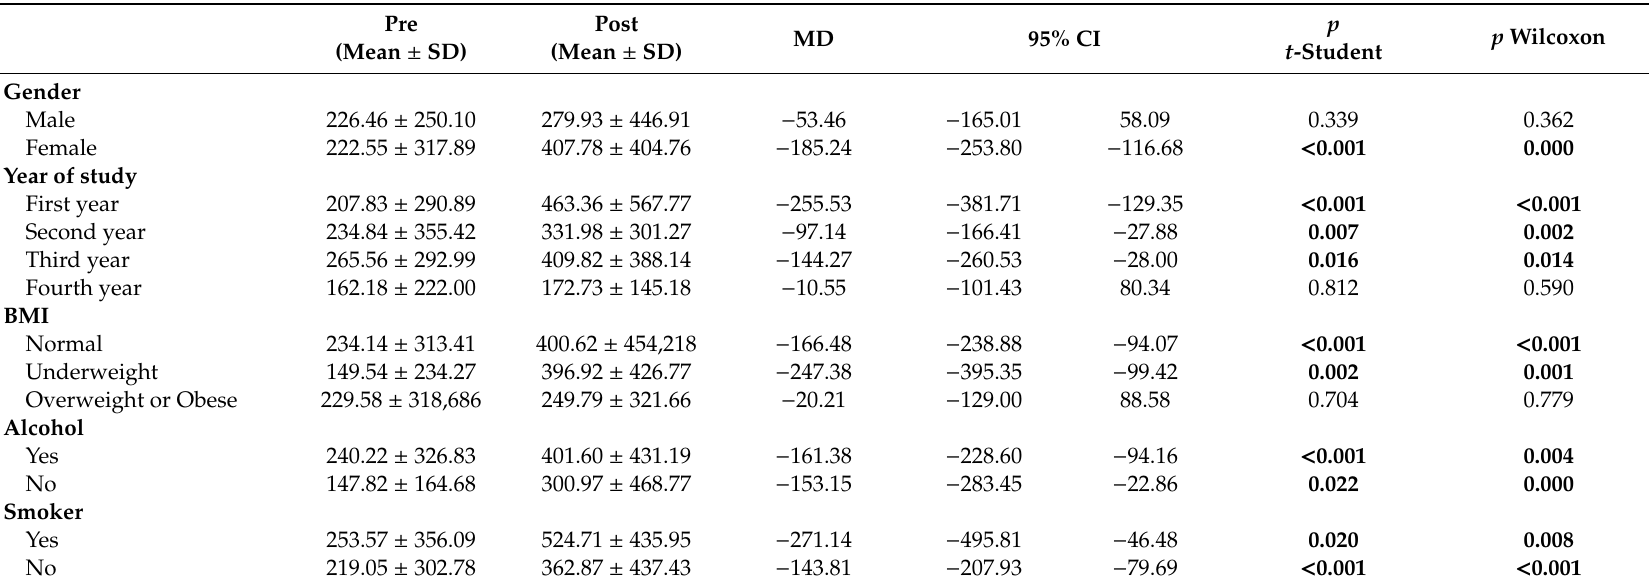
Table 3. Physical activity: total minutes per week pre and post by